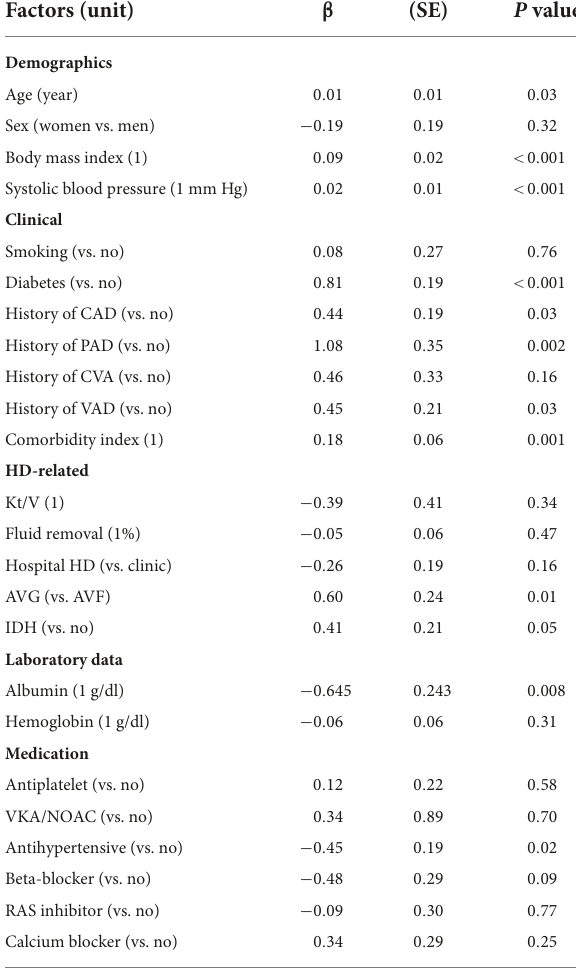
TABLE 2 Factors correlated with Systolic BPV.